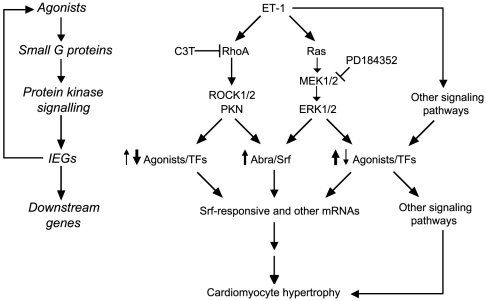
Schematic of signaling and gene expression responses to ET-1 in cardiomyocytes.Agonists (e.g. ET-1) activate intracellular signaling pathways including small G proteins and protein kinases. C3T and PD184352 inhibit activation of RhoA and ERK1/2, respectively. Intracellular signaling pathways modulate expression of immediate early genes (IEGs) including Abra/Srf that participate in RhoA-mediated regulation of cardiomyocyte hypertrophy. These and other transcription factors (TFs) promote expression of downstream genes. Agonists are also produced that act in autocrine/paracrine loops to initiate further cycles of signaling/gene expression. These networks eventually culminate in hypertrophy.